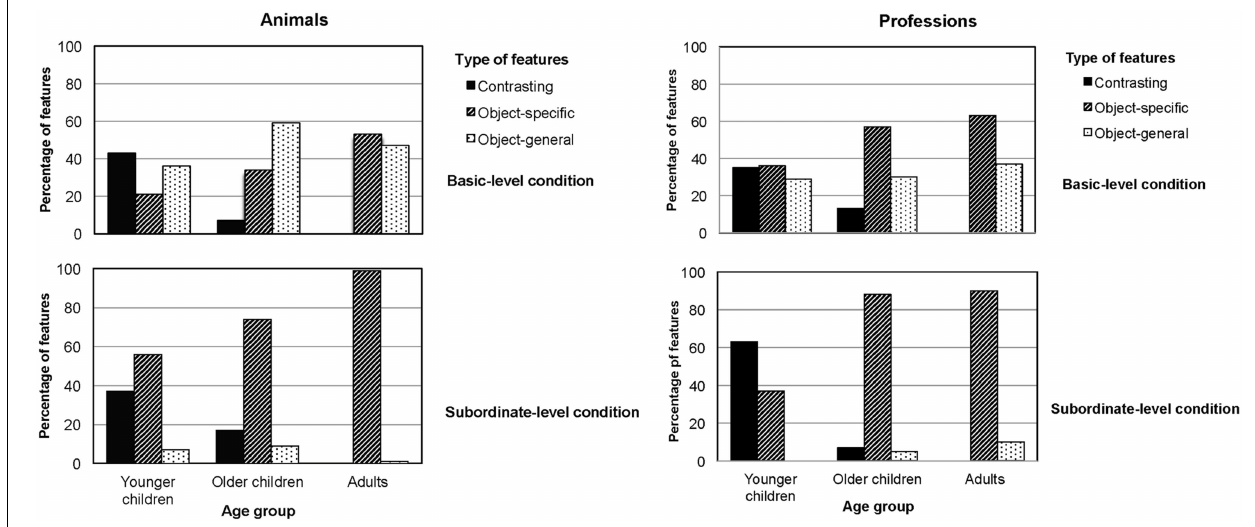
FIGURE 4 | Percentage of features (rounded) generated, displayed by age group, feature type (object-general, object-specific, and contrasting), and inclusiveness (basic level and subordinate level) in the animal domain (left panel) and the profession domain (right panel).